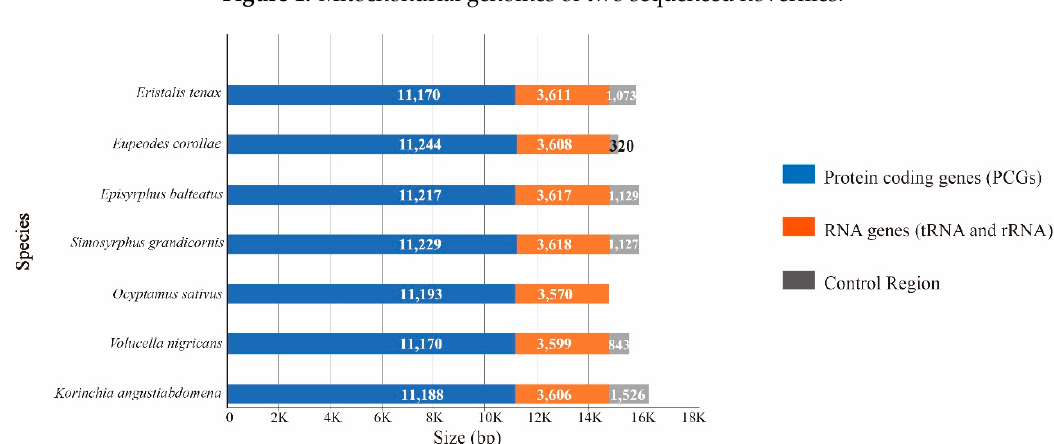
Figure 1. Mitochondrial genomes of two sequenced hoverflies.